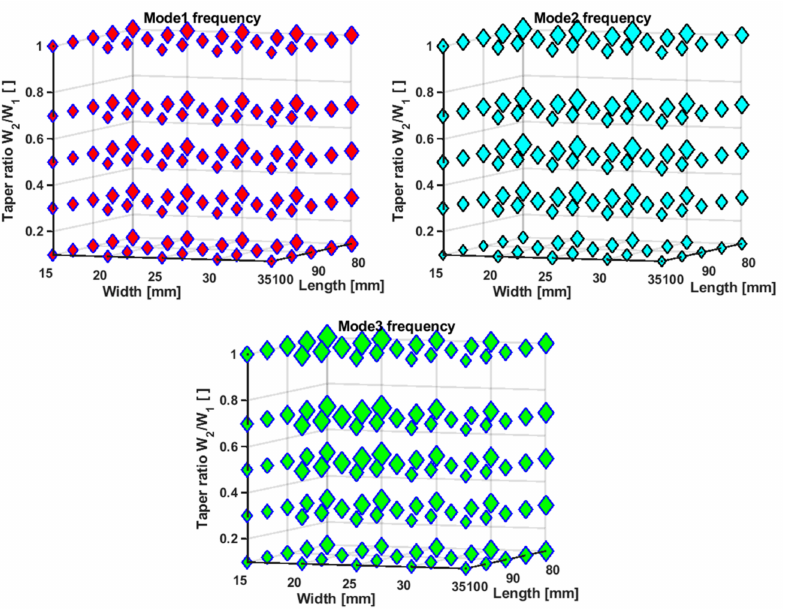
Figure 9. Tendency graphs for the frequency of the first three resonant modes of a multimode bimorph segmented tapered cantilever-based PVEH.